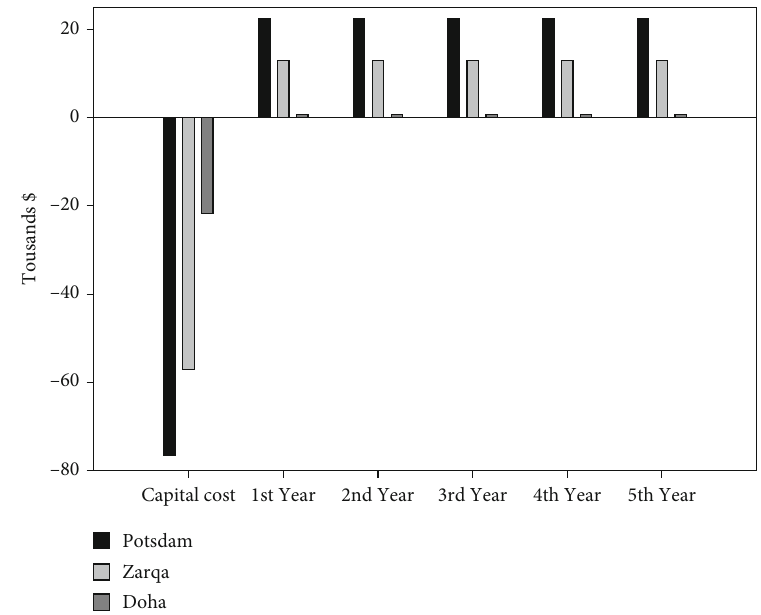
Figure 11: Cash fl ow diagram for the three selected